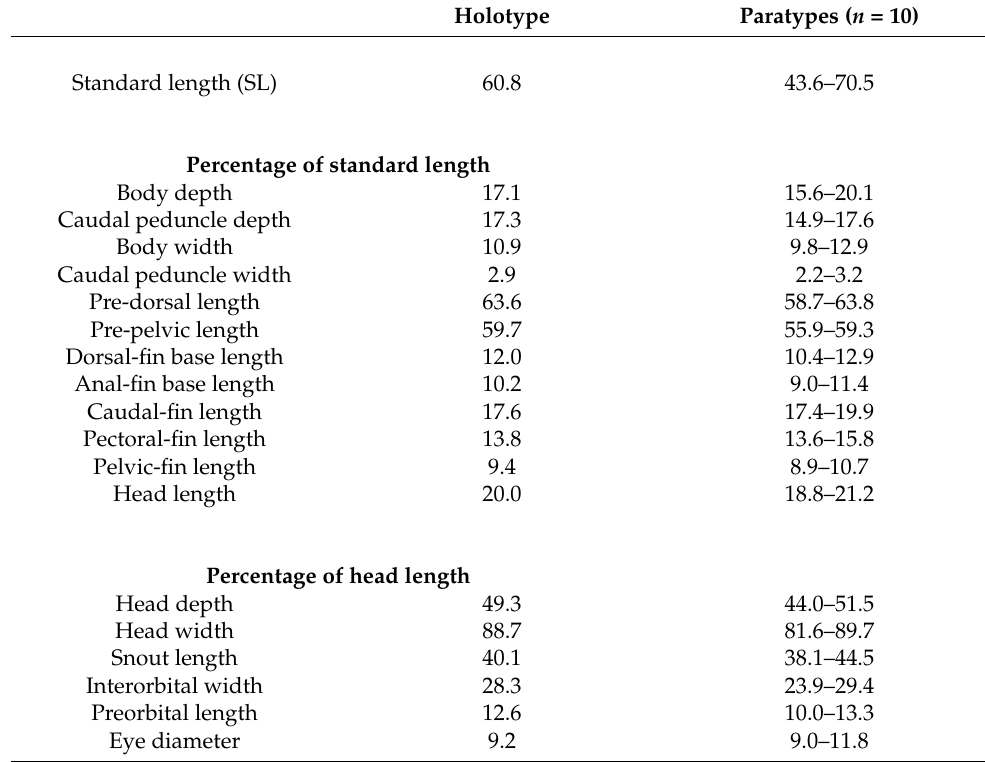
Table 1. Morphometric data of Trichomycterus garbei Costa, Azevedo-Santos & Katz sp. nov. Holotype Paratypes ( n =